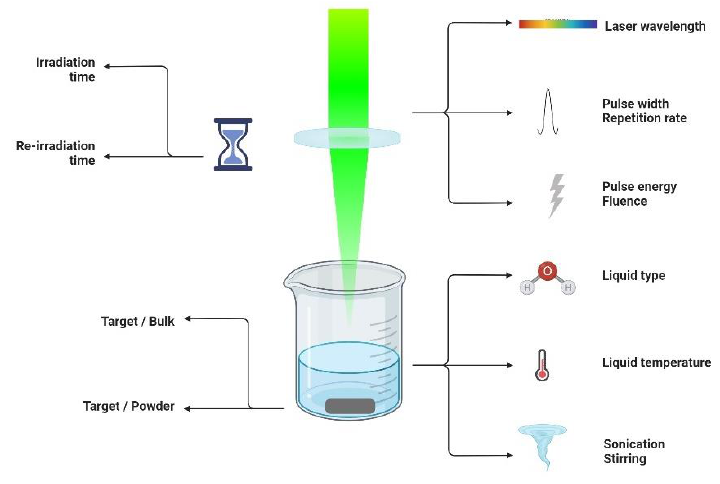
Figure 2. PLAL experimental parameters. (Created with BioRender.com)